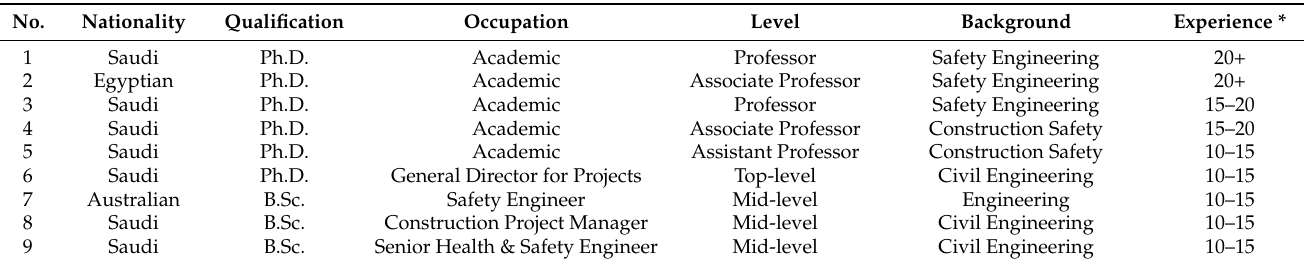
Table A1. Construction safety experts’